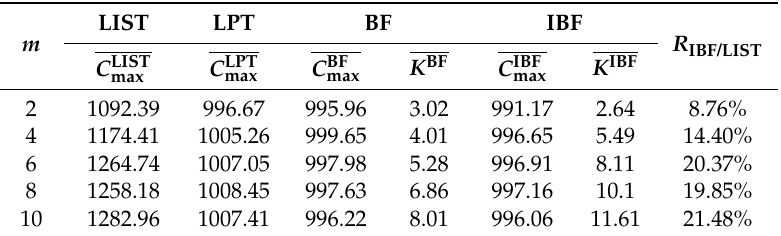
Table 2. Comparison of LIST, LPT, BF, and IBF